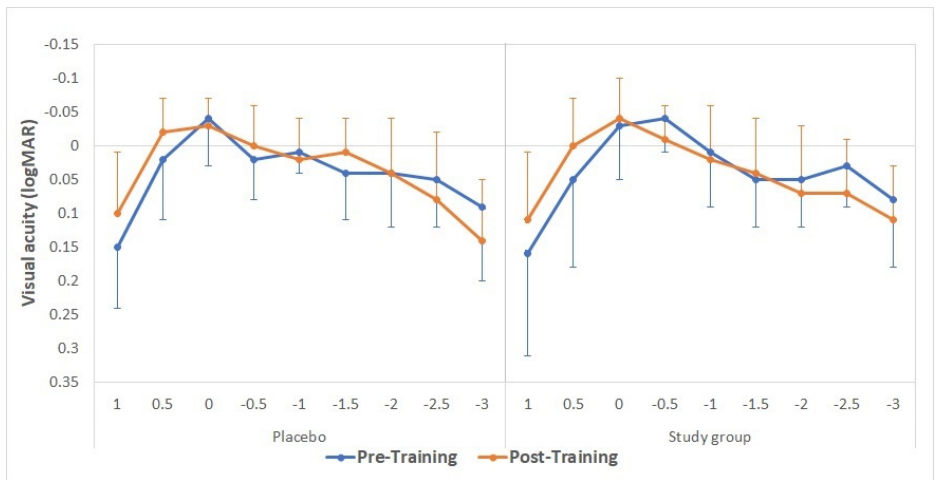
Figure 3. Mean defocus curves obtained before (continuous lines) and after (discontinuous lines) the training, considering the defocus levels from − 3.00 to +1.50 D (with a 0.50 D step size) for the placebo (green) and study groups (purple).